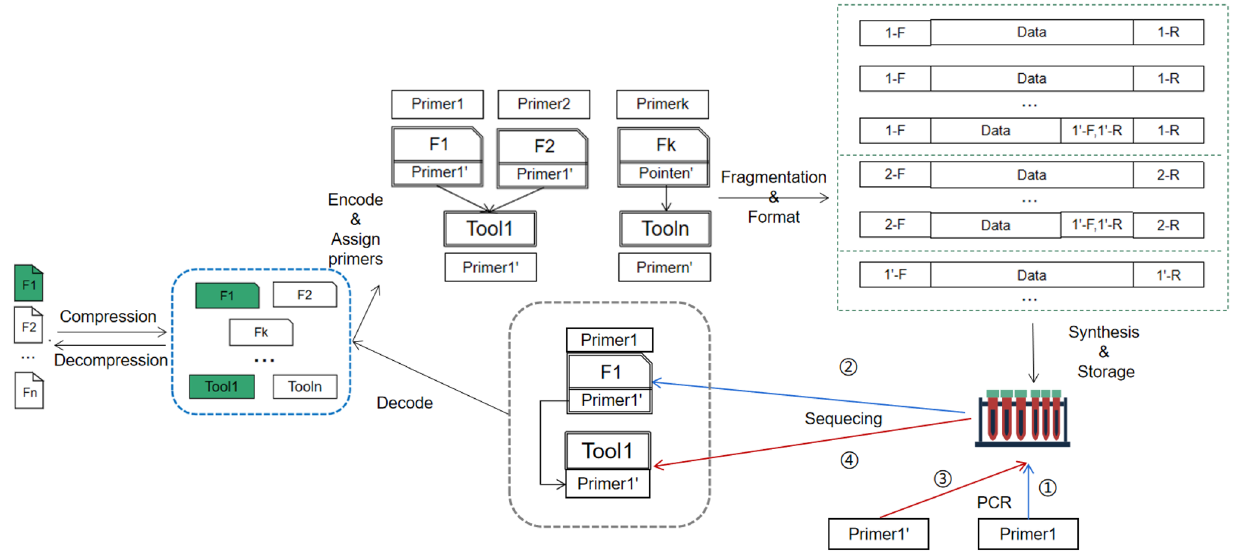
Figure 4. M-1CI Method: As with the previous method, data is compressed before it is stored. However, the compressed data files are not continuously stored in a single file as shown in the blue dashed box, instead, they are compressed into separate files. Next, for random read access, we index a file by adding a file primer to it (say, Primer1 to F1 ), encode the file into a base DNA sequence, then append the tool’s primer to the data file (say, Primer1’ to F1 ), and finally, perform the sequence segmentation and add tool’s primers to each fragment. Suppose in the reverse process if file F1 is read, Step 1 (cid:31) is to amplify it by Primer1 , then in Step 2 (cid:31) , Primer1’ of Tool1 , together with F1 , can be obtained after a round of sequencing. Then, by using Primer1’ , the tool file is amplified in Step 3 (cid:31) , followed by Step 4 (cid:31) to obtain the Tool1 file by another round of sequencing. After decoding, Tool1 is used to decompress F1 to obtain the original data. Overall, the sequencing procedure is performed twice.